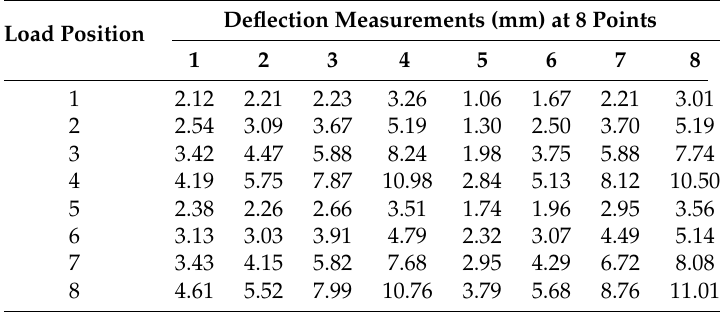
Table A3. Constructed deflection ( D )